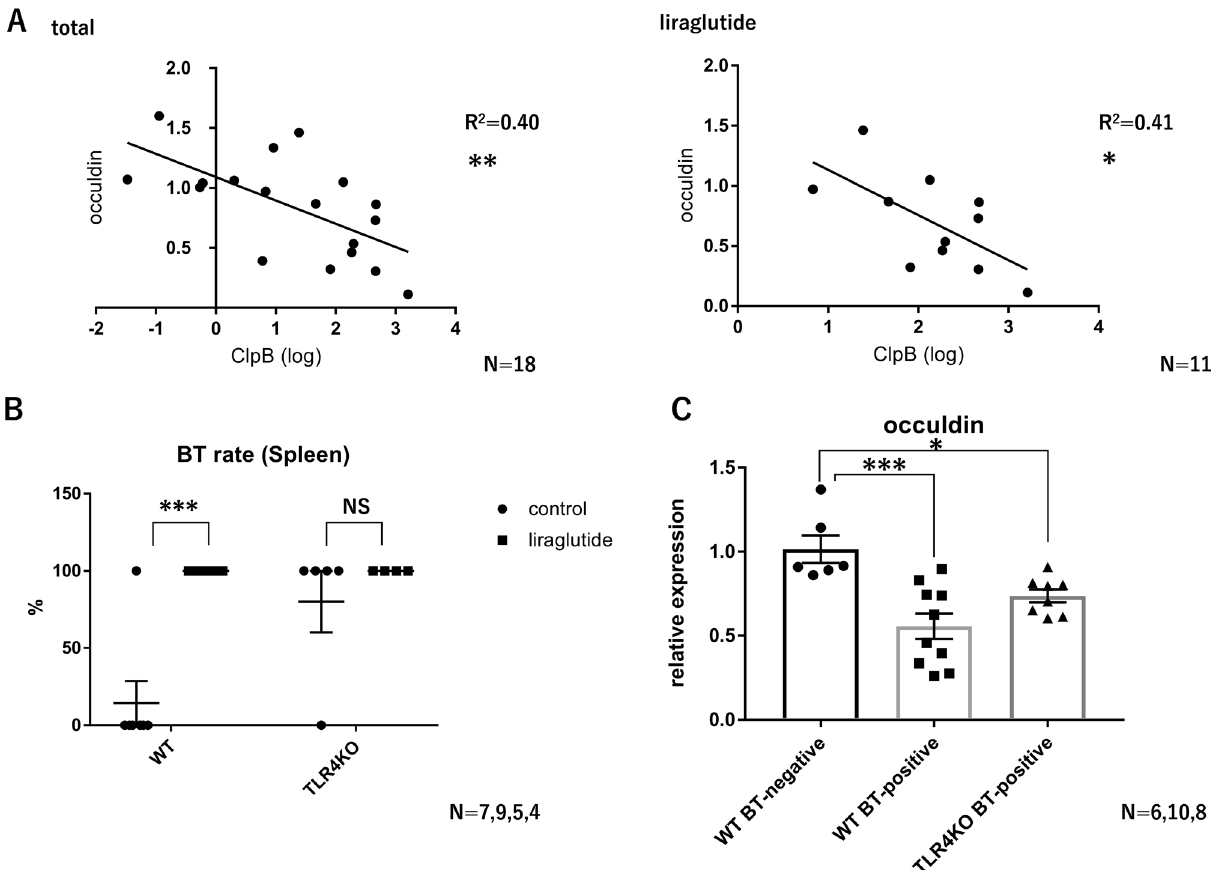
Figure 6. In DSS colitis, liraglutide promotes bacterial translocation. ( A ) Correlation between the relative expression of ClpB in cecal contents and occludin in cecal tissue in mice with DSS colitis with or without acute liraglutide administration (total, n = 18; liraglutide, n = 11). ( B ) ClpB positive rate in the spleen under DSS colitis conditions in wild-type (WT) mice and TLR4KO mice with or without acute liraglutide administration (WT control, n = 7; WT liraglutide, n = 9; TLR4KO control, n = 5; TLR4KO liraglutide, n = 4). ( C ) Cecal occludin gene expressions according to ClpB positivity (bacterial translocation [BT]) under DSS colitis conditions in wild-type (WT) mice and TLR4KO mice (WT BT-positive, n = 6; WT BT-negative, n = 10; TLR4KO BT-positive, n = 8). All values represent the mean ± SEM. * P < 0.05, ** P < 0.01, *** P < 0.001; NS, not significant by linear regression analysis ( A ), two-way ANOVA with multiple comparison test ( B ), and one-way ANOVA with multiple comparison test ( C ). The coefficient of determination is denoted as R 2 . All figures were drawn using GraphPad Prism 7 (www. graph pad. com) and Microsoft’s PowerPoint 2016 (www. micro soft.